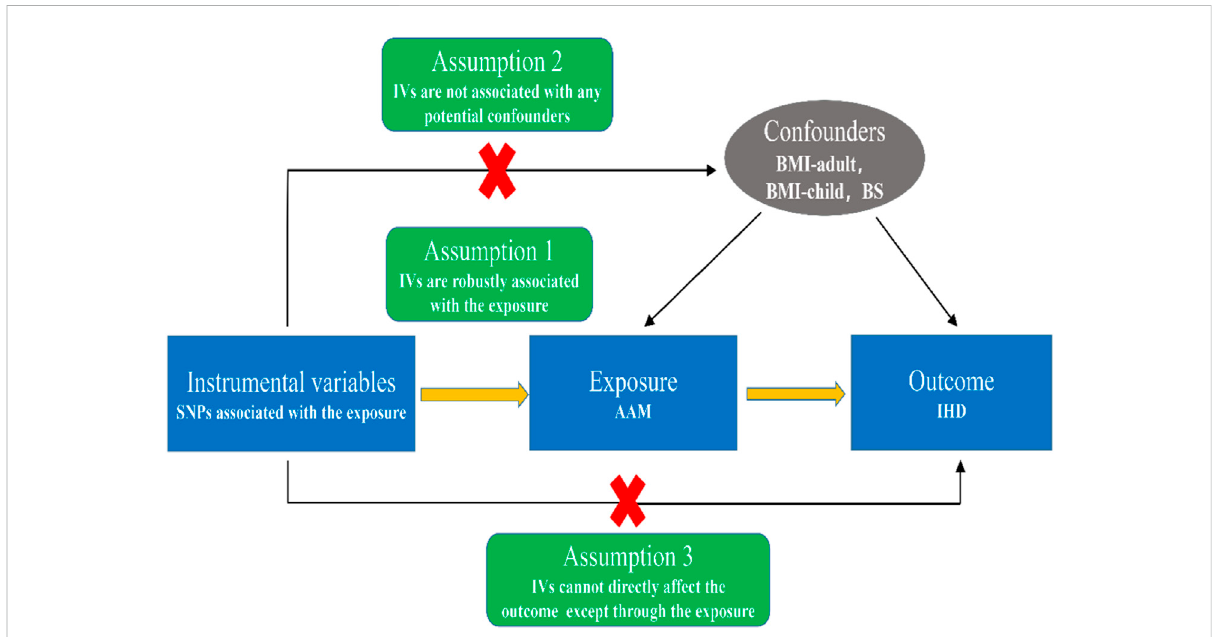
FIGURE 1 Schematicdiagram showingtheassumptionsofMendelian randomization analysis.Abbreviations:SNPs,single nucleotidepolymorphisms; IVs, instrumental variables; AAM, age at menarche; IHD, ischemic heart disease; BMI, body mass index; BS, biological